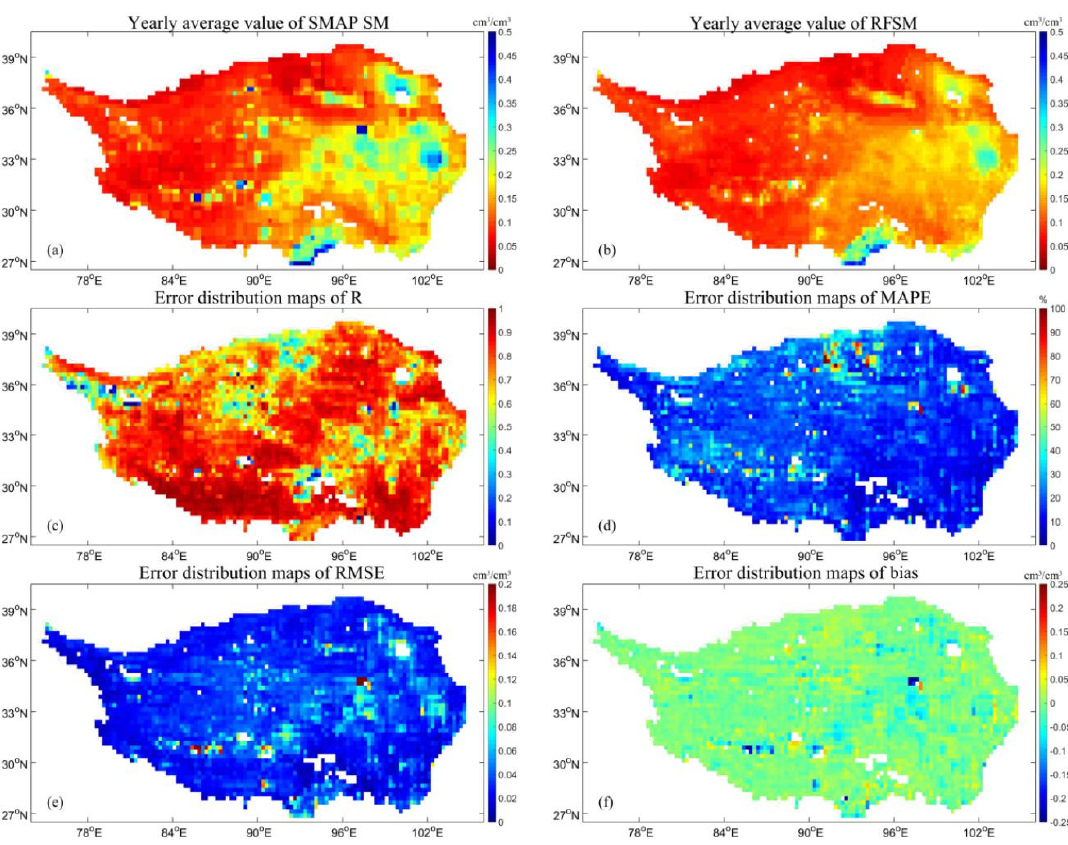
Figure 5. Yearly average values of ( a ) SMAP SM and ( b ) RFSM and error distribution maps of RFSM vs. SMAP SM over the test period (May 2017 to May 2018): ( c ) correlation coefficient ® ; ( d ) mean absolute percentage error (MAPE); ( e ) root mean square error (RMSE) and ( f ) bias values.